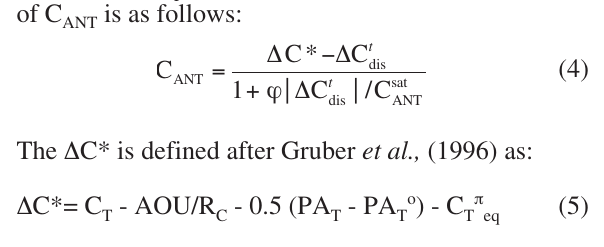
and C =AOU/R term in ANT bio C